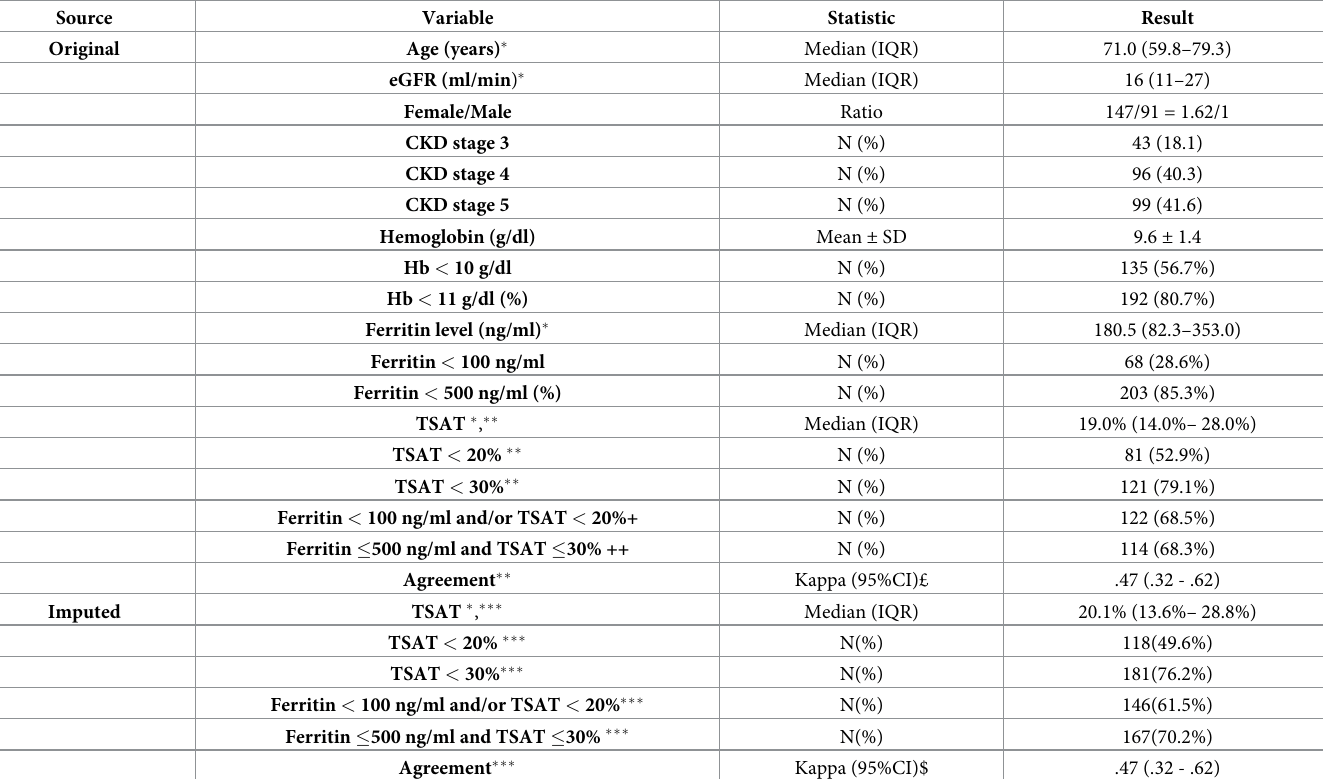
Table 1. Characteristics of the 238